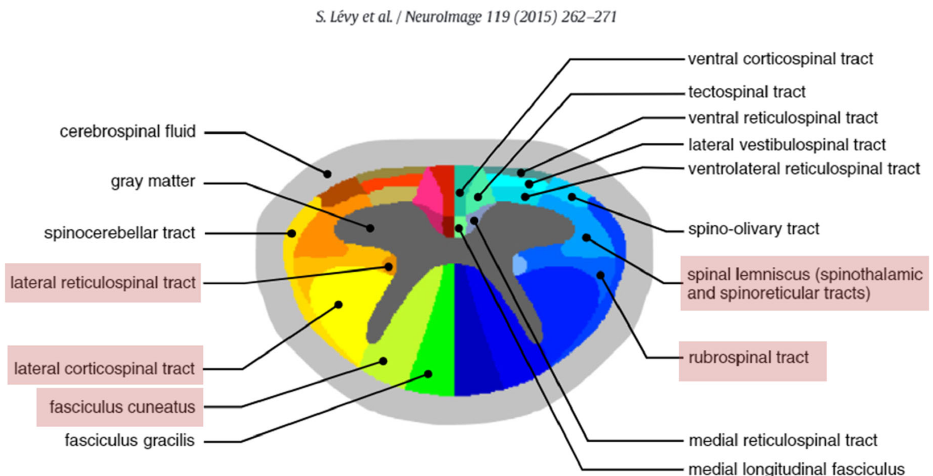
Figure 2. Spinal cord white matter tracts. The colored atlas of the spinal cord white matter has been adapted from Lévy et al., 2015 [29].